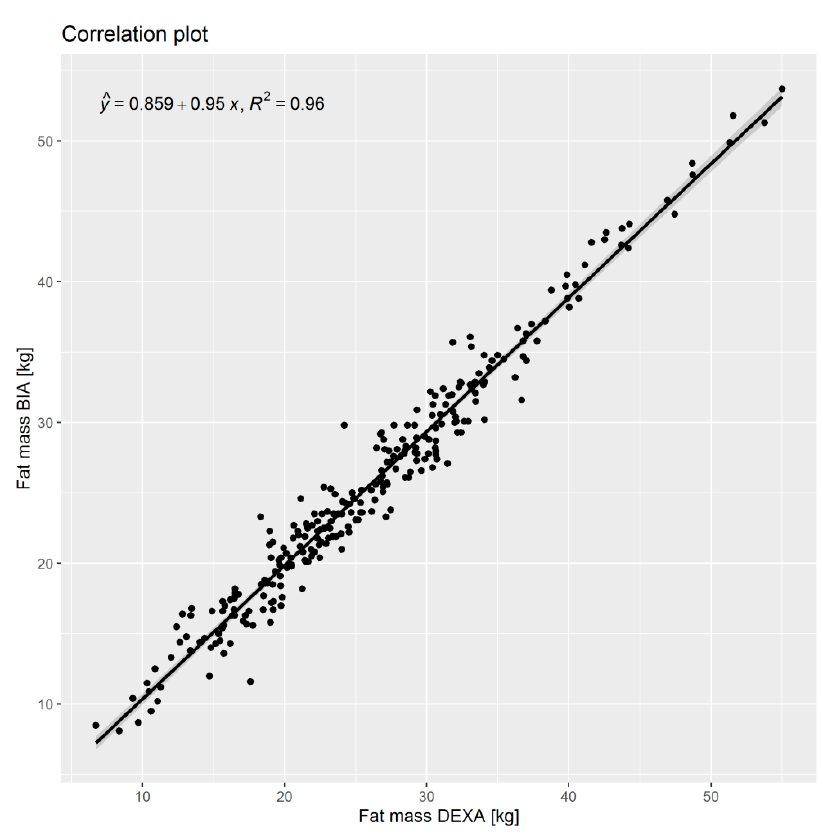
Figure A1. Comparison between fat mass derived from dual-energy X-ray absorptiometry (DXA) and bioimpedance analysis (BIA).